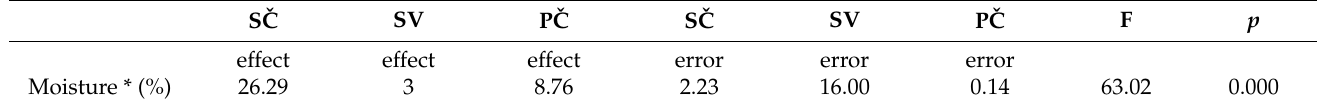
Table 4. Analysis of variance of four wood dust samples with variable, moisture (%).